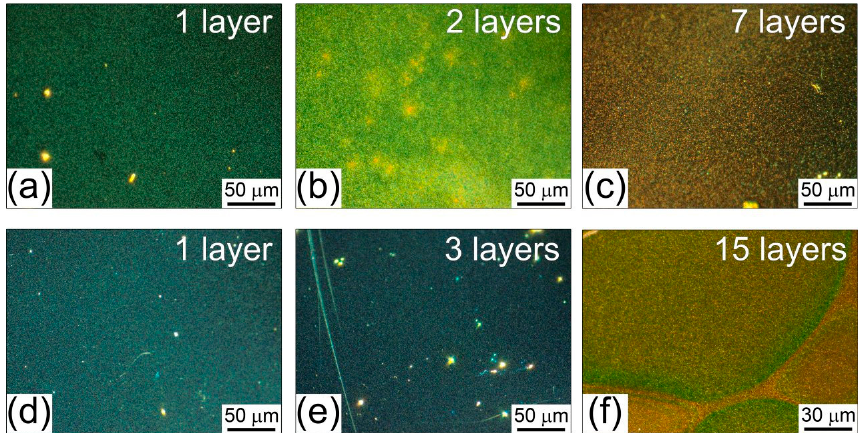
Figure A1. Dark field optical microscopy images of ( a – c ) HTD and ( d – f ) LTD thin film BFO with di ff erent numbers of deposited